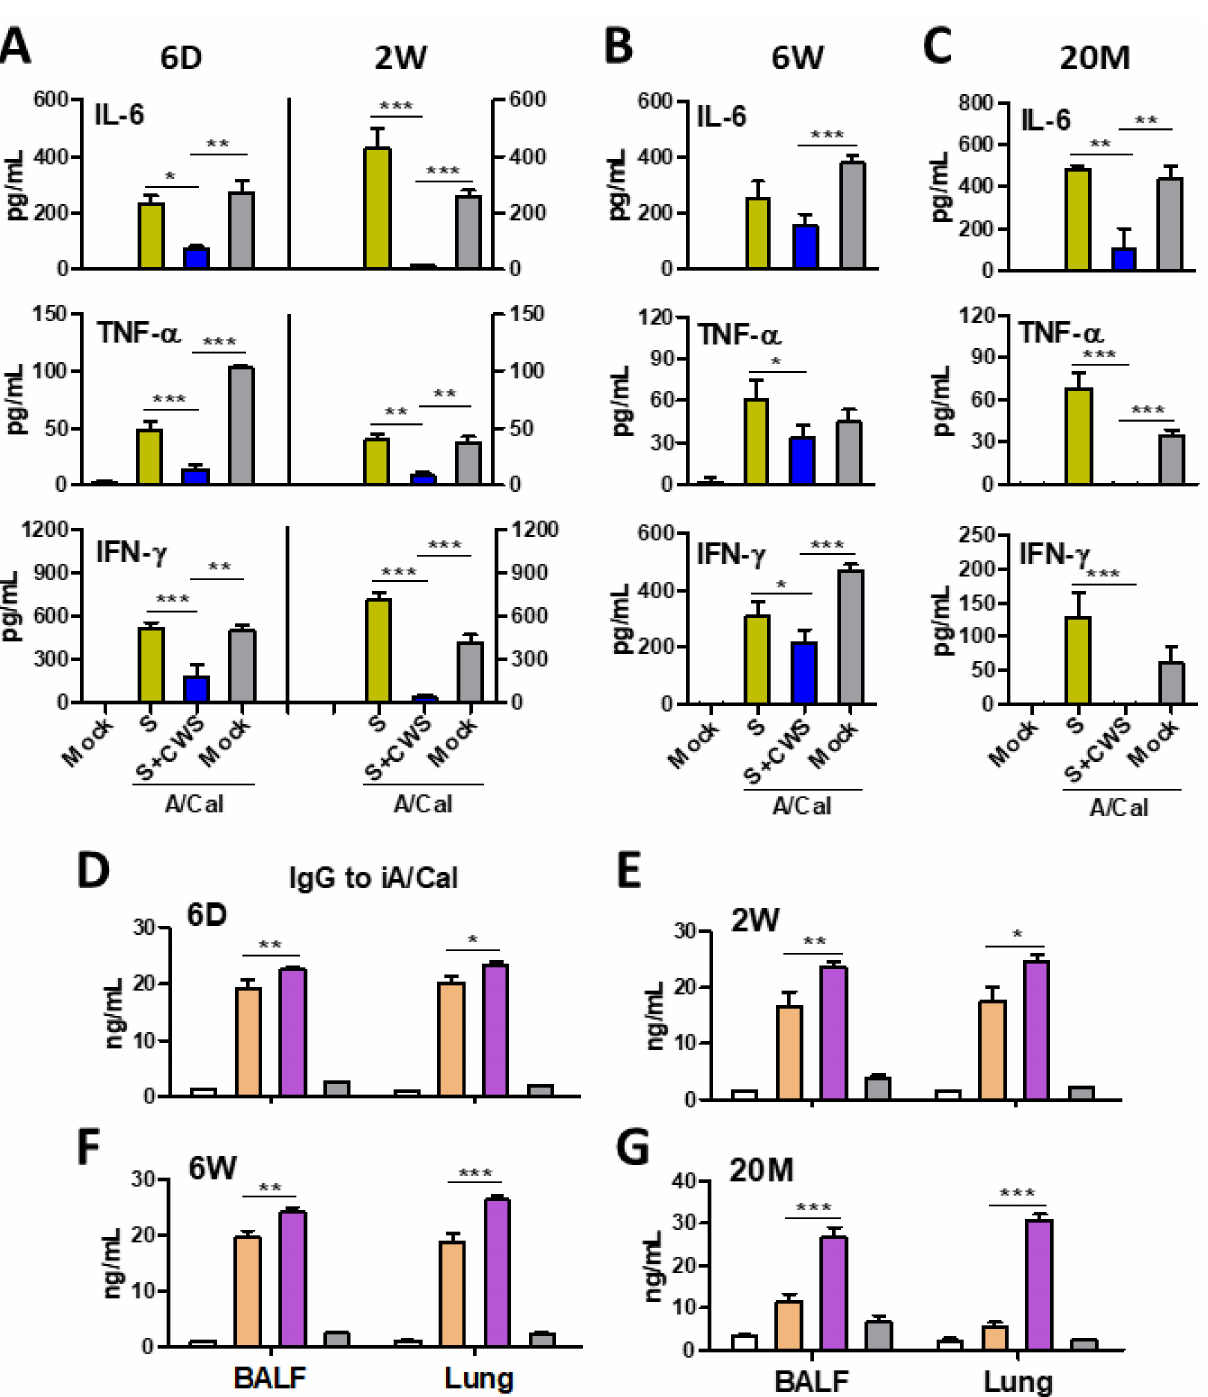
Figure 6. Inflammatory cytokines and virus specific IgG antibody responses in lung samples from vaccinated mice after infection. BALF and lung lysates were collected at 7dpi after challenging of immunized mice ( n = 10 for 6 D, 2 W, and 6 W mice, n = 5 for 20 M mice) to evaluate protective efficacy. The levels of cytokine and antibody were determined by ELISA. ( A ) Inflammatory cytokines (IL-6, TNF- α , and IFN- γ ) in lung samples collected from 6 D or 2 W mice with prime-boost. ( B ) Lung inflammatory cytokines from 6 W adult mice with prime. ( C ) Lung inflammatory cytokines from 20 M aged mice with prime-boost. ( D – G ) Virus specific IgG antibody levels in BALF and lung samples collected at 7 dpi from the 6 D, 2 W, 6 W, and 20 M mouse groups. Statistical significance was calculated by using one-way ANOVA and a Dunnett’s multiple-comparison test. Error bars indicate the mean ± SEM. *; p < 0.05, **; p < 0.01, ***; p <